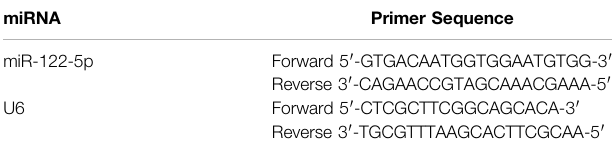
TABLE 1 | Primer sequences for qRT-PCR in this study. miRNA